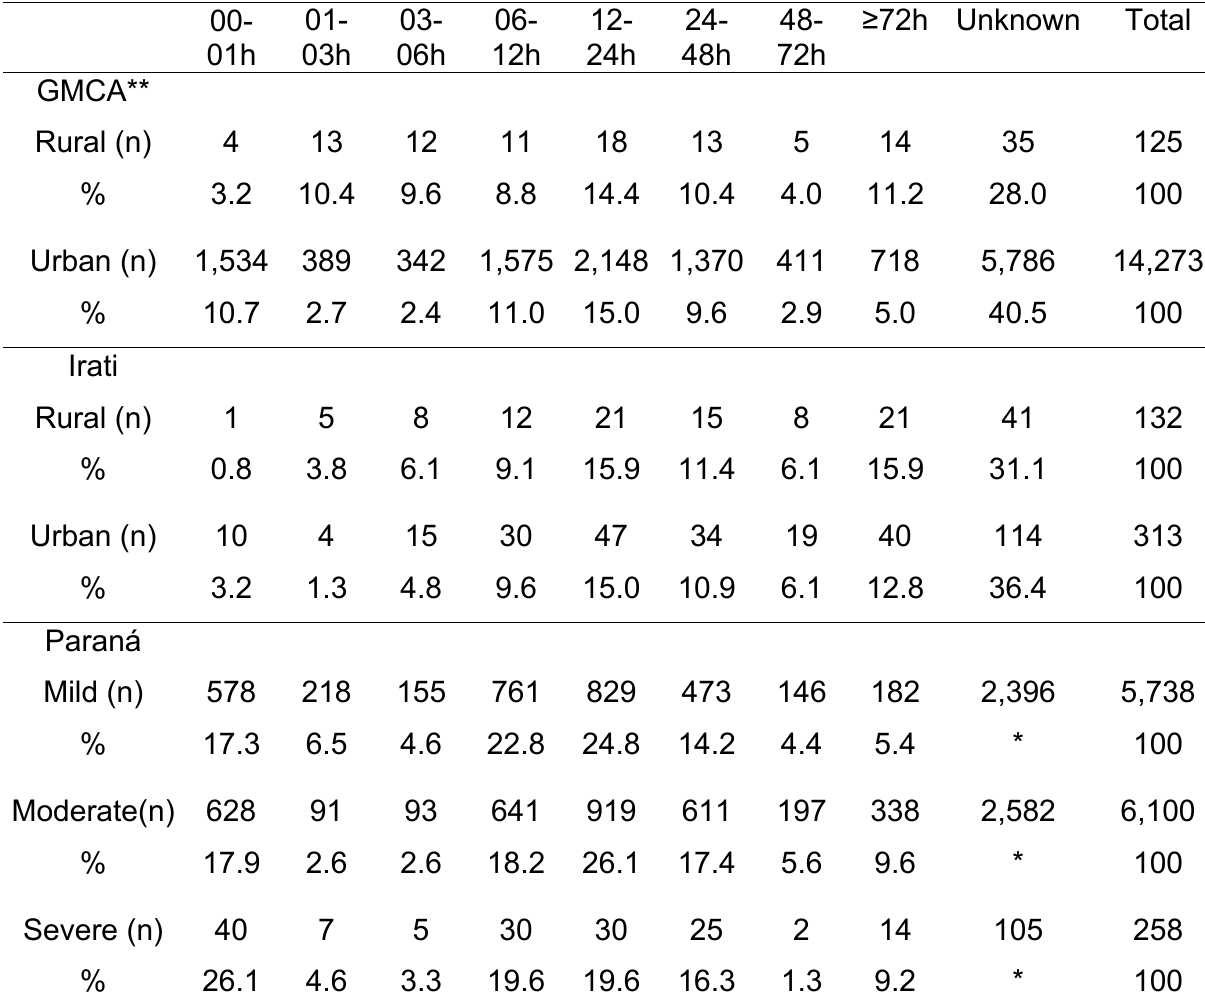
Table 2: Time elapsed between the Loxosceles bite and medical treatment, according to urban versus rural area and severity of the bite, Paraná State, Brazil,